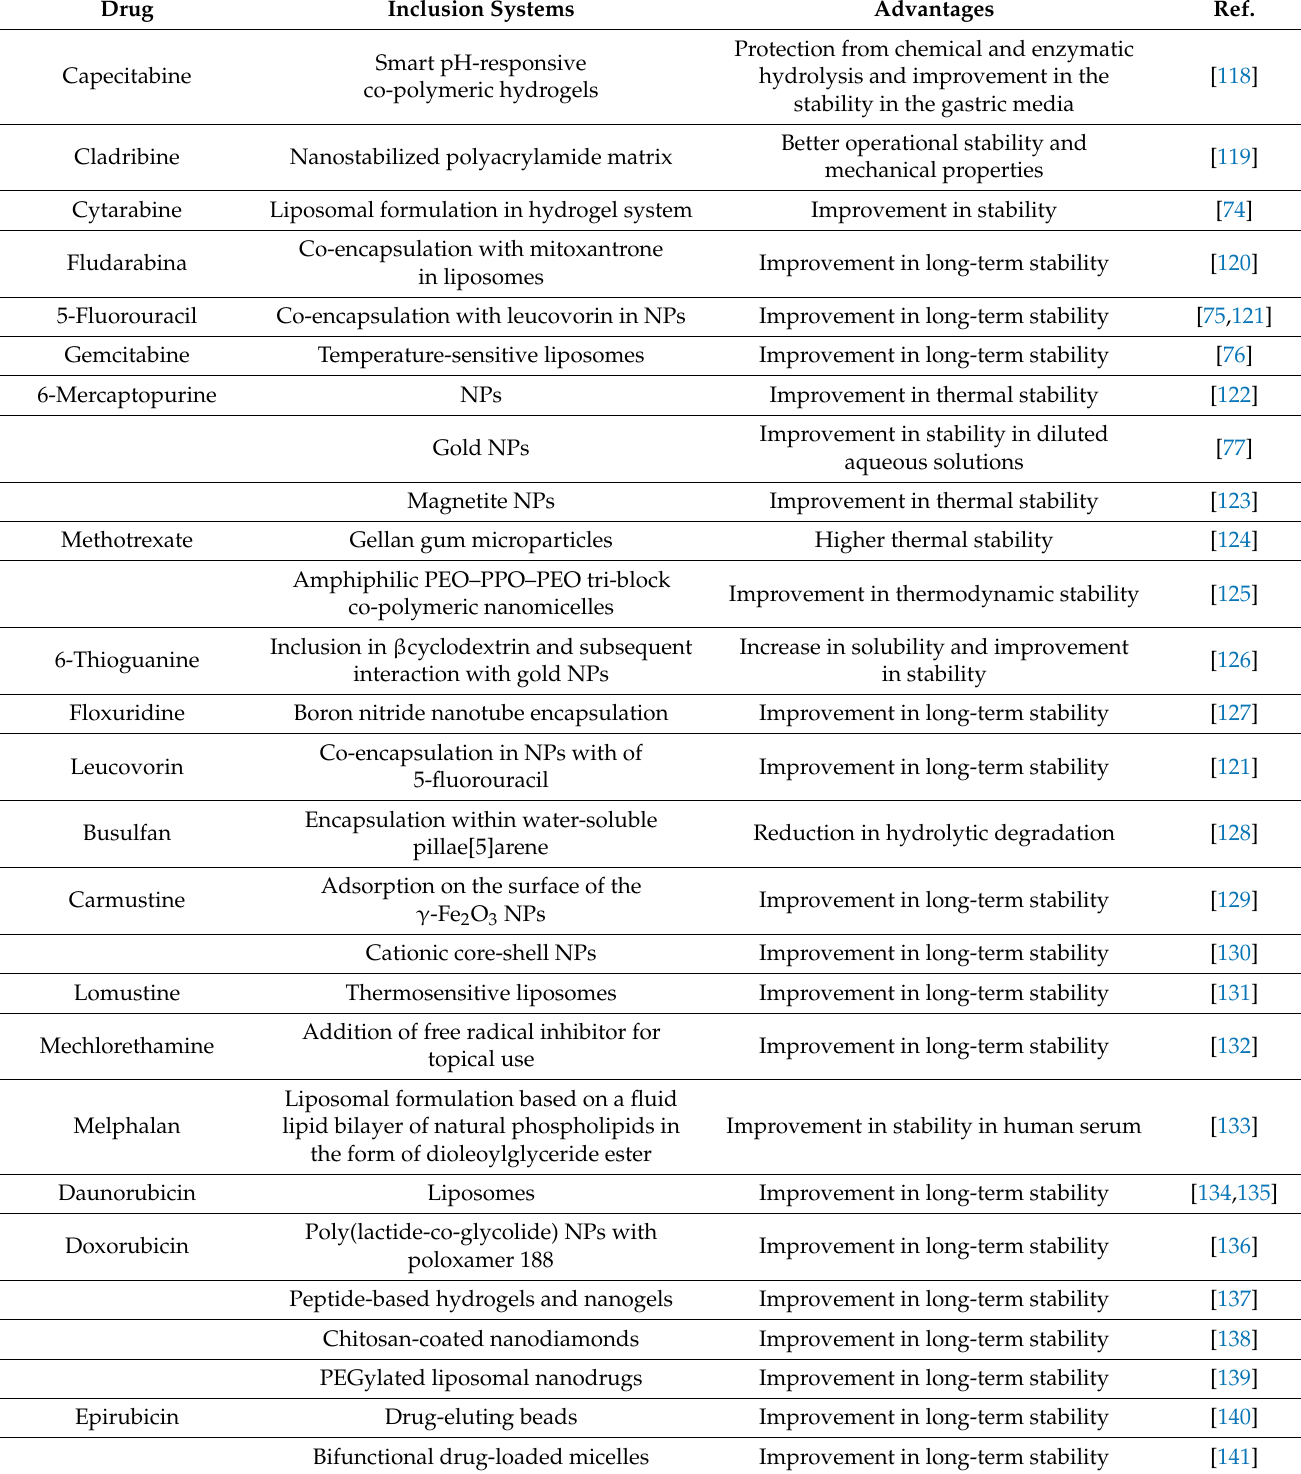
Table 2 lists most of the applied inclusion systems for anticancer drugs and prodrugs and the advantages obtained from the proposed formulation. Table 2. Inclusion systems and their advantages in protecting the anticancer